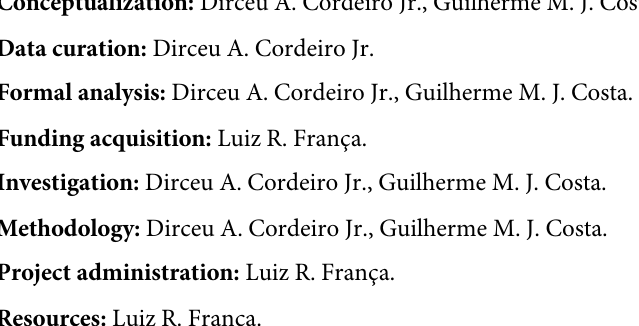
S1 Table. Number of individuals per species collected in the rainy and dry